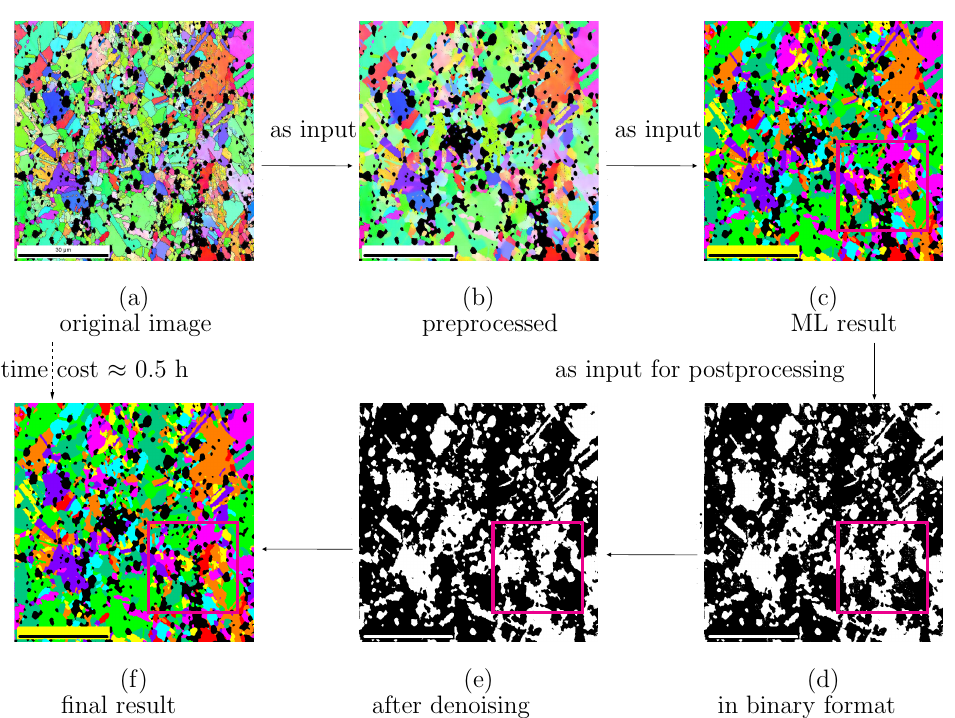
Fig. 5: Autonomous image segmentation for MP12-2 Ag/SnO 2 composite ( Tab. 1 ): (a) original EBSD Figure 5. Autonomous image segmentation for MP12-2 Ag/SnO 2 composite (Table 1): ( a ) original EBSD image; (b) resulted image after denoising by the preprocessing; (c) resulted image after ML/random forest image; ( b ) resultant image after denoising by the preprocessing; ( c ) resultant image after the ML/random model; (d) monotonic image obtained by transforming (c) as preparation for denoising in postprocessing; forest model; ( d ) monotonic image obtained by transforming ( c ) as preparation for denoising in postpro- cessing; ( e ) monotonic image after postprocessing; ( f ) final segmented color image after (e) monotonic image after postprocessing; (f) final segmented color image after post-processing.